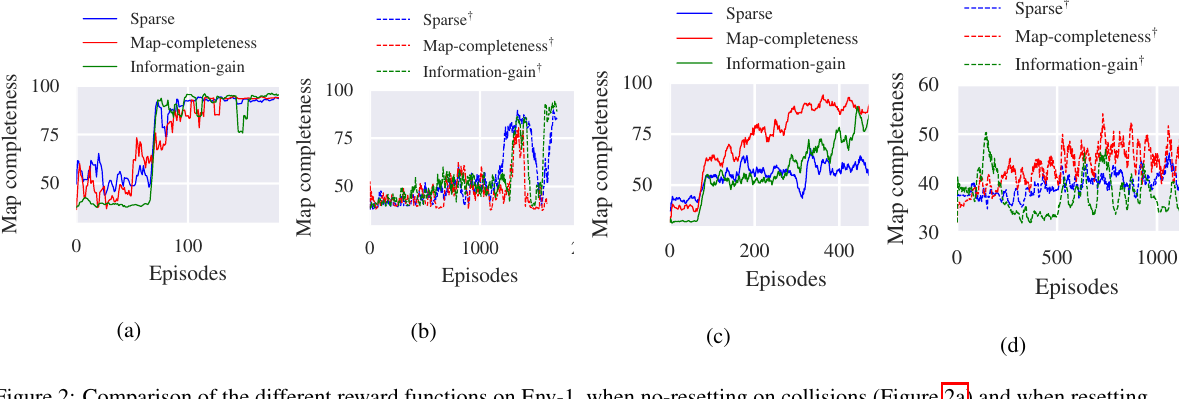
Figure 2: Comparison of the different reward functions on Env-1, when no-resetting on collisions (Figure 2a) and when resetting (Figure 2b) and comparison of the different reward functions on Env-2, when no-resetting on collisions (Figure 2c) and when resetting (Figure 2d).